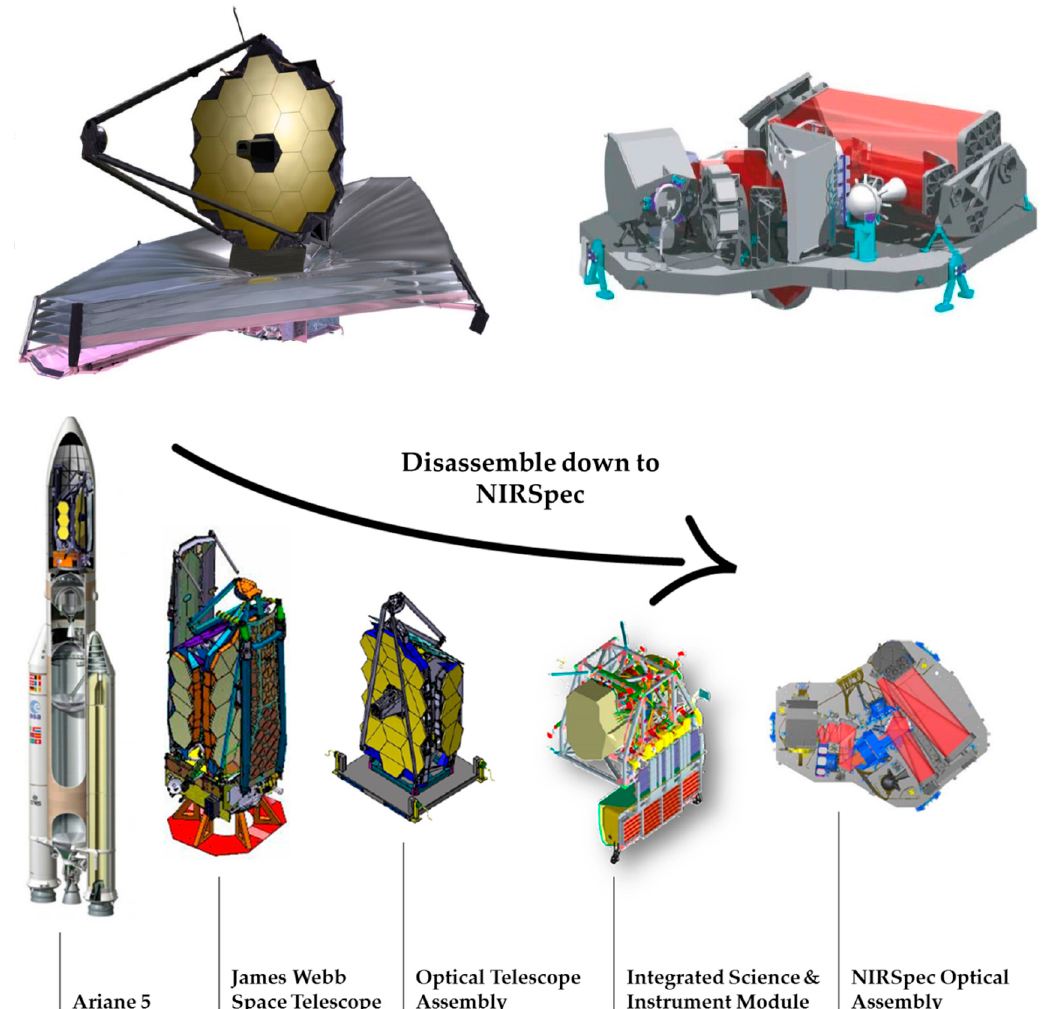
Figure 1. The James Webb Space Telescope (JWST) (top left) in deployed configuration and Near-Infrared Spectrograph (NIRSpec) (top right). On bottom, JWST is disassembled towards NIRSpec [5].